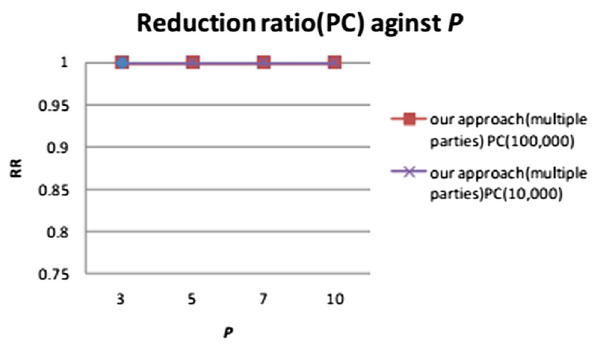
Fig. 12 PC with varying p for multi-part private blocking